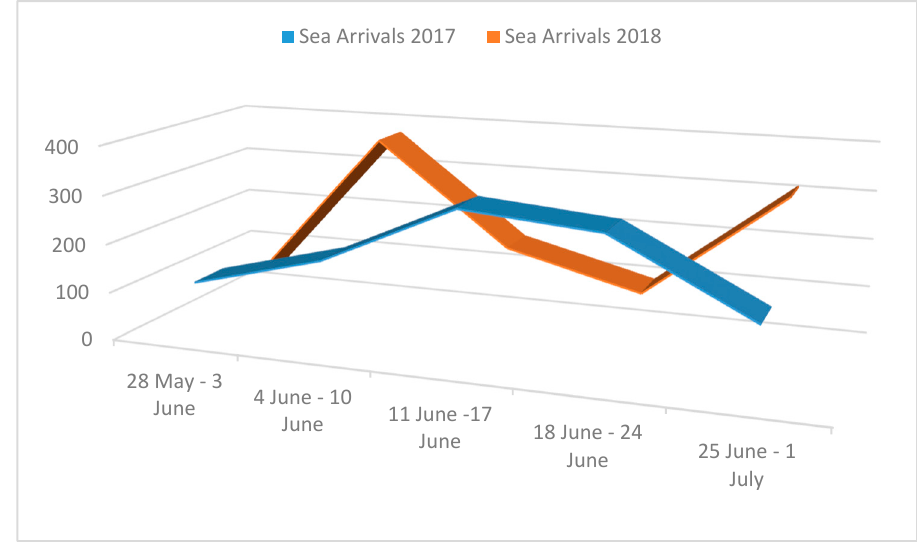
Figure 2. Comparison of sea arrivals on Lesvos island between 2017 and 2018 (UNHCR 2018b).